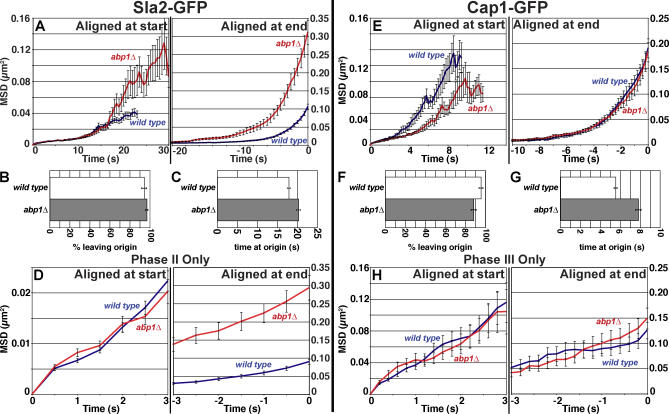
Quantitative Motion Analysis of Actin Patches in Null Mutants Lacking Abp1Cells express Sla2-GFP (A–D) or Cap1-GFP (E–H). (A and E) MSD plots for wild-type and mutant patches aligned at the start (left) or end (right) of their lifetimes. The curves on the left are truncated at the median lifetime. (B and F) Percentage of patches that leave the origin. Mean of values for three segregants is shown. (C and G) Average time at the origin, from the appearance of a patch until it moved away or disappeared. (D) Phase II movement only. For each patch, data prior to movement were removed. Only patches that moved away from the origin were included. (H) Phase III movement only. For each patch, data prior to the time the patch traveled 200 nm were removed. Only patches that moved more than 200 nm from the origin were included.Strain numbers and number of patches: (A–C) Wild-type, YJC5457–9; 157, 141, and 151. abp1Δ, YJC5454–6; 95, 118, and 85. (D) Strains as in (A–C). Numbers of patches: wild-type – 153, 135, 135. abp1Δ – 92, 112, 84. (E–G) Wild-type, YJC5681–3; 74, 75, and 72. abp1Δ, YJC5684–6; 62, 58, and 57. (H) Strains as in (E–G). Numbers of patches: wild-type – 64, 69, 64. abp1Δ – 44, 43, 51 Error bars are ± standard error.